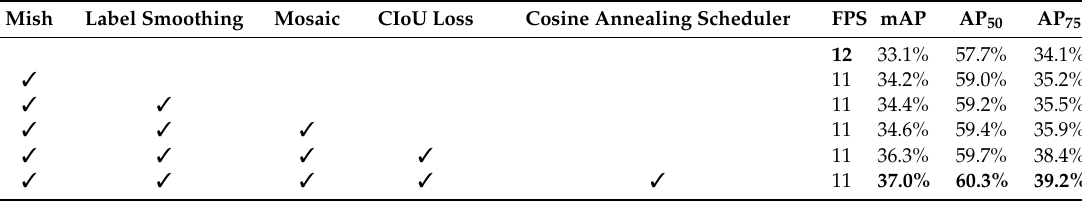
Table 1. The e ff ect of e ff ective tricks in the baseline on recognition